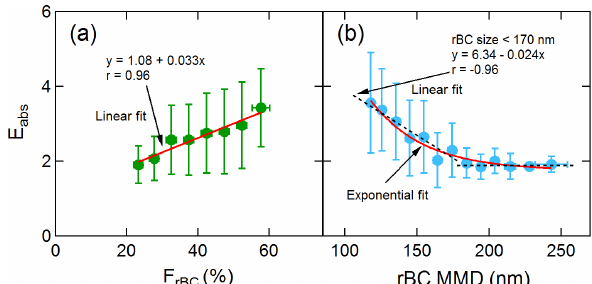
Figure 10. Absorption enhancement ( E abs ) versus (a) the number fraction of thickly coated refractory black carbon ( F rBC ) and (b) the mass median diameter (MMD) of rBC during the campaign. The error bars correspond to the standard deviations of E abs , F rBC , and